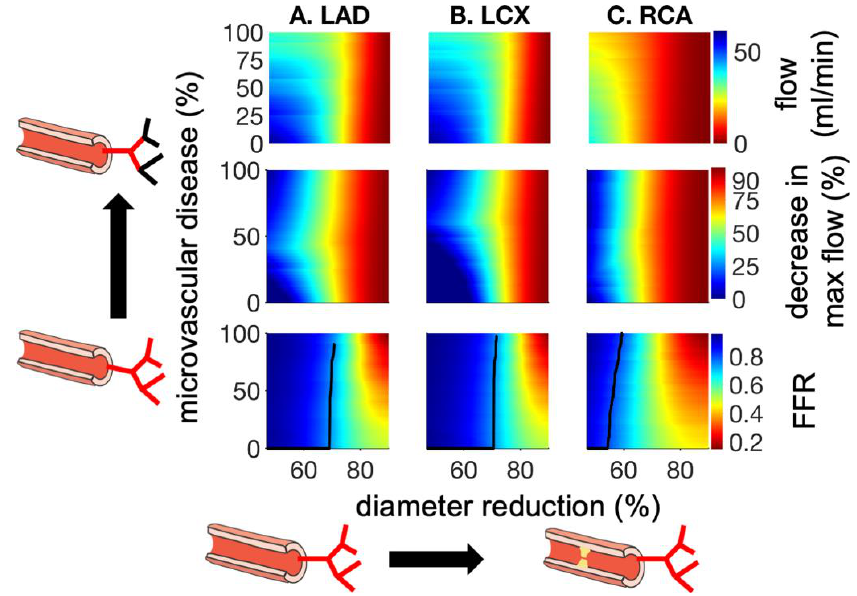
Figure 5. Dependence of flow rate (top row), maximum flow (middle row), and mean FFR (bottom row) on microvascular resistance increase (microvascular disease, vertical axis in all panels) and vessel diameter (horizontal axis, all panels). Columns A – C show LAD, LCX, and RCA results, respectively. The black line in the bottom row demarcates the FFR = 0.8 threshold.